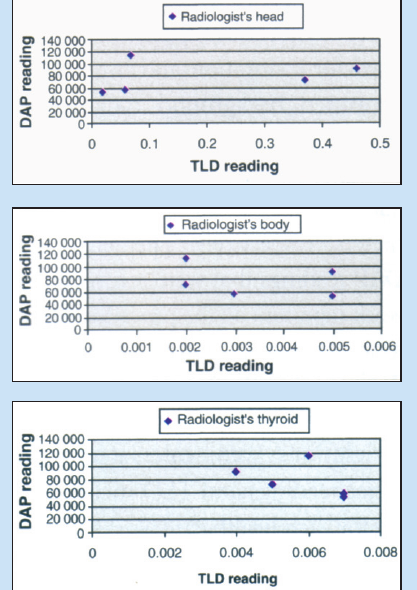
Fig. 1. Correlation between the DAP meter and radiologists’TLD meter readings.